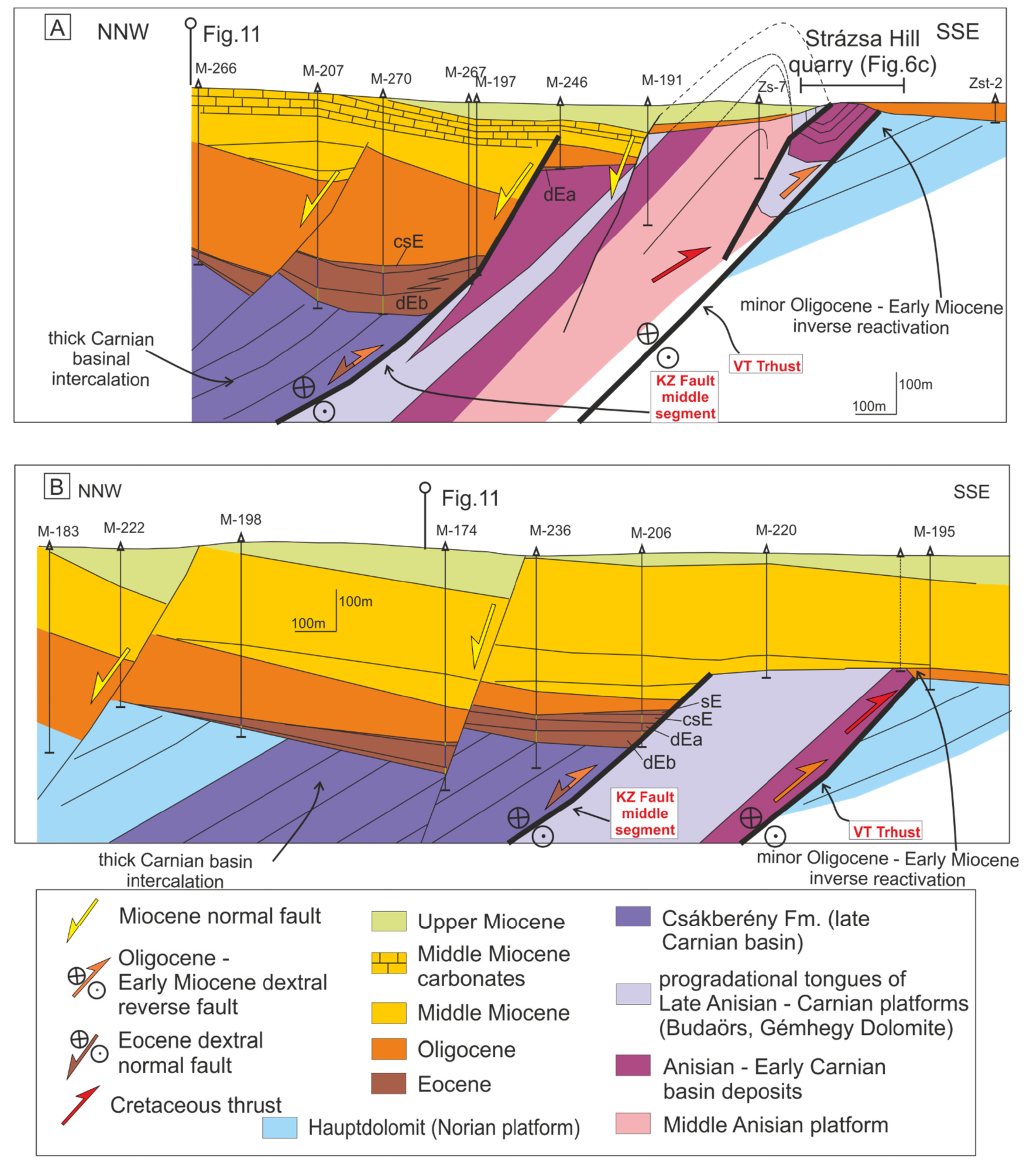
Figure 9. Sections across the middle segment of the KZ Fault. ( A ) Section across the eastern part of the middle segment of the KZ Fault. ( B ) Section across the western part of the middle segment of the KZ Fault. For location of the sections, see Figure 4. The abbreviations “Fig.” refer to figures of this work.